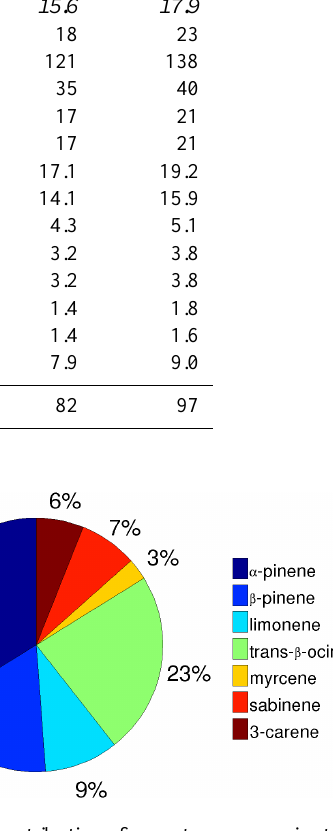
Figure 1. Relative contribution of monoterpene species to monoter- pene annual global total averaged over the 1980–2010 period. Con- sidered monoterpene species are listed in the enclosed